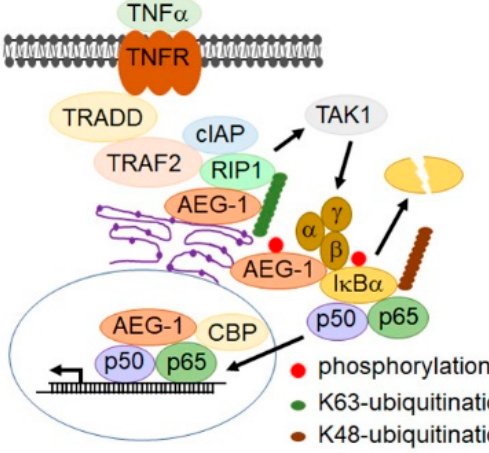
Figure 2. Mechanisms by which AEG-1 activates NF-B. The cartoon shows that the tumor necrosis factor (TNF)- induced signaling cascade leads to NF-B activation and the role of AEG-1 in this cascade. AEG-1, anchored on the endoplasmic reticulum (ER) membrane, associates with the upstream K63-ubiquitinated activators of NF- κ B, such as RIP1 and TNF receptor associated factor 2 (TRAF2), facilitating their accumulation. AEG-1 is directly phosphorylated by IKK at serine 298, which is essential for the K48-ubiquitination of I κ B followed by proteasomal degradation, facilitating the nuclear translocation of p50/p65 NF- κ B. In the nucleus, AEG-1 interacts with p65 NF- κ B and the CREB-binding protein (CBP) and functions as a bridging factor between NF- κ B and basal transcriptional machinery, promoting NF- κ B-induced transcription. IKK, and are indicated as α , β and γ in the